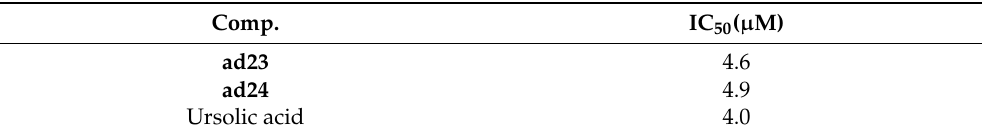
Table 40. PTP1B inhibition activity of the compounds ( ad23 – ad24 ). Comp.